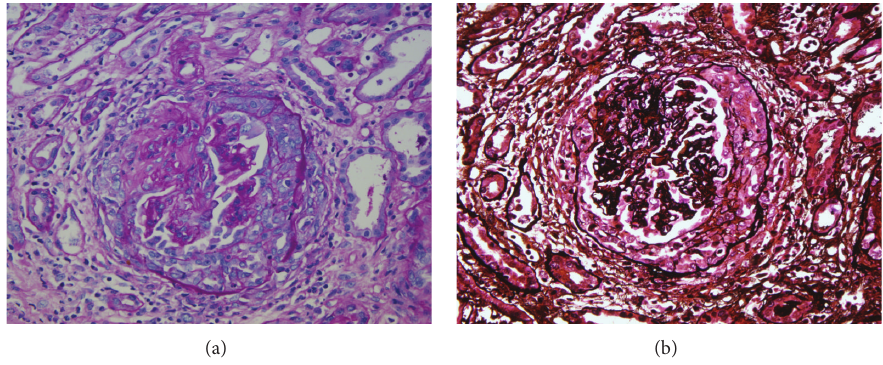
Figure 3: Glomerulus with extracapillary proliferation. Left side with PAS stain, 20x, and to the right with methenamine-silver stain,